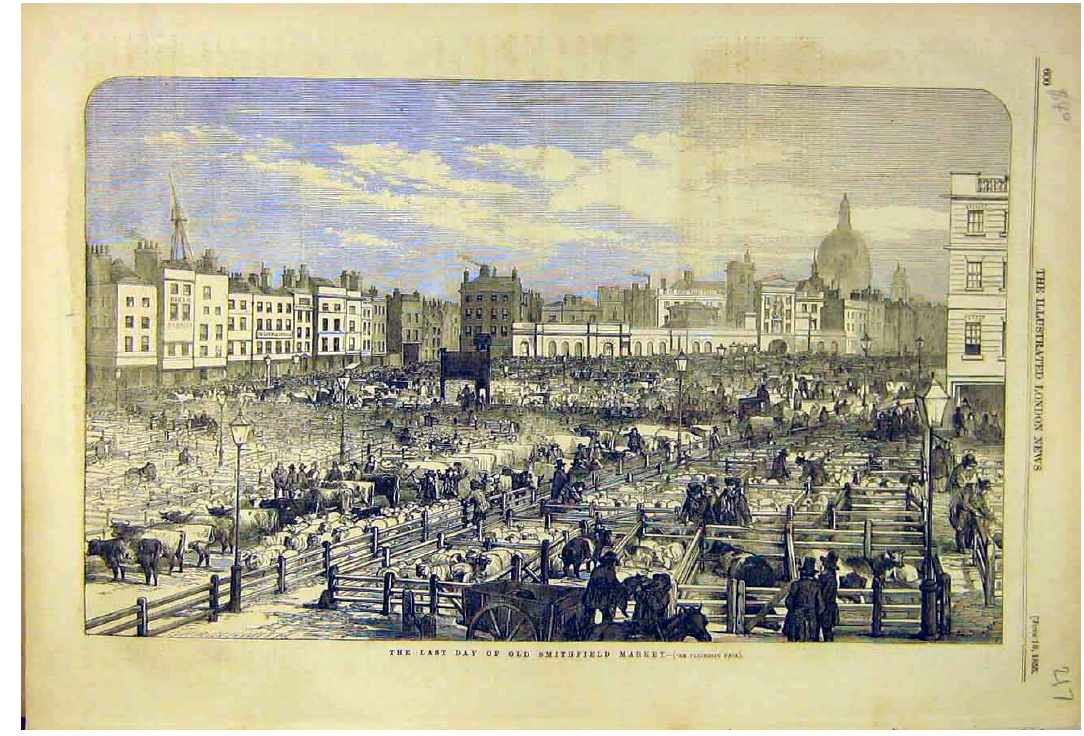
Figure 2: ‘ The Last Day of Old Smithfield Market ’ Source: The Illustrated London News , 16 June 1855: